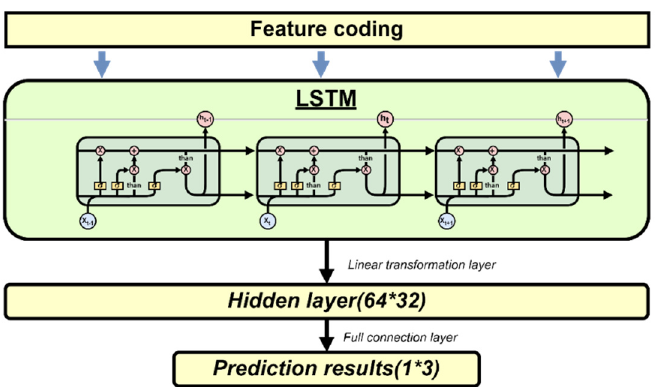
Figure 8. Perceptual evaluation and prediction model of truck cranes based on LSTM (KE–LSTM).